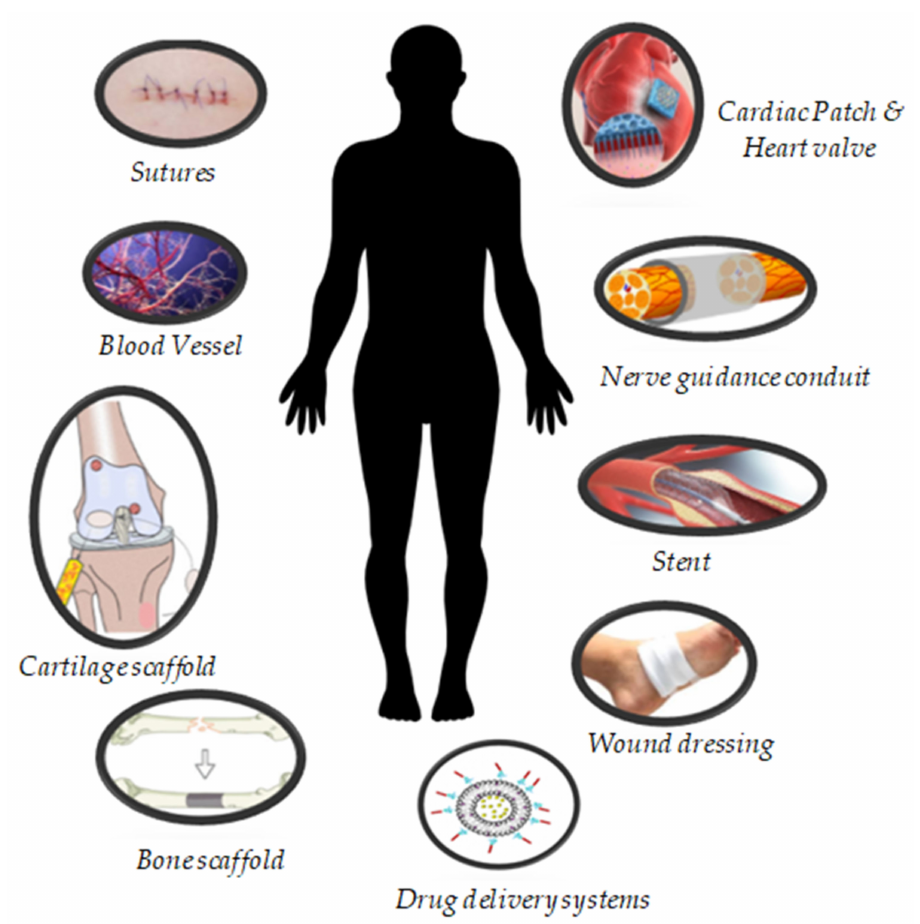
Figure 2. Applications and development of PHAs for the biomedical sector, especially in the tissue engineering